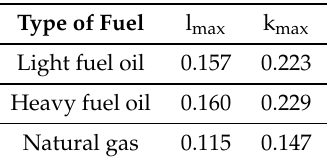
Table 1. Indicative maximum values of theoretical contents of carbon dioxide and carbon monoxide for the fuels used in the